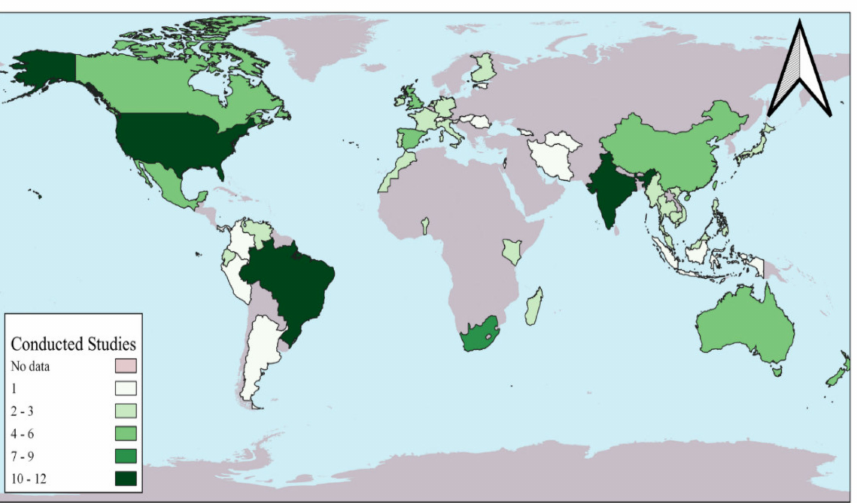
Figure 2. Distribution and number of studies about prioritizing conservation choices for flora and fauna